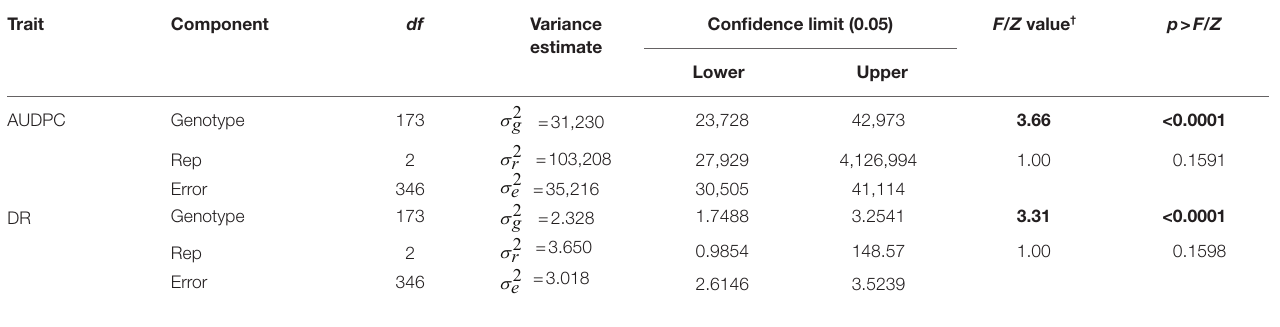
TABLE 2 | Analysis of variance for area under disease progress curve (AUDPC) and Sclerotinia basal stalk rot disease rating (DR) scores measured among individuals of the HA 89/ Helianthus praecox AB-QTL population tested in the